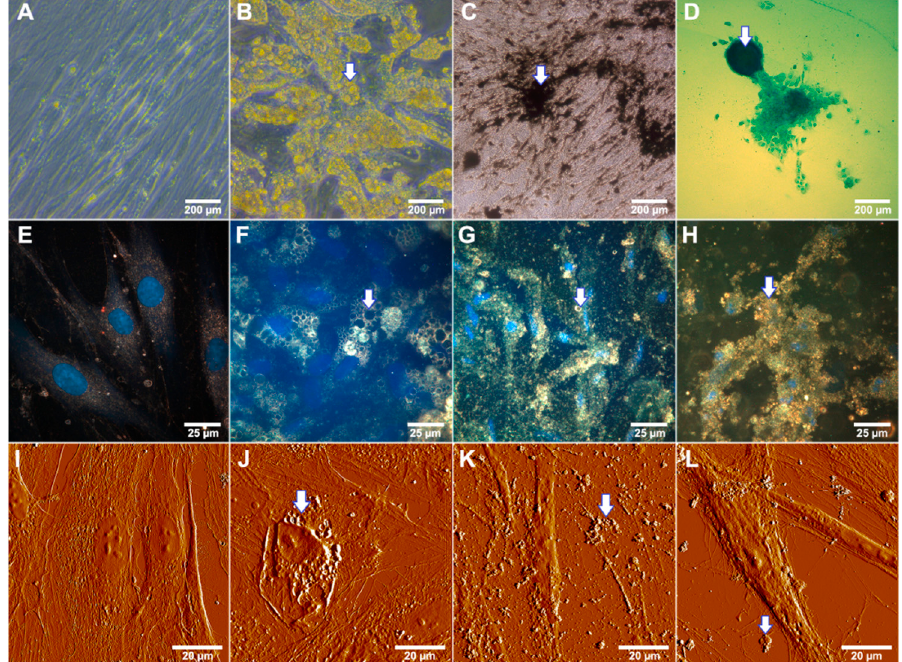
Figure 3. Differentiation potential of equine adipose derived mesenchymal stem cells after 14 d incubation in differentiat- ing media. Arrows indicate characteristic changes of cellular morphology. ( A )—cells incubated in the presence of α -MEM (negative control); ( B )—cells grown under adipogenic conditions (note a huge amount of yellow colored lipid droplets); ( C )—von Kossa staining of cells differentiated to the osteoblasts under osteogenic conditions (note the black stained cal- cium accretion); ( D )—alcian blue staining of cells differentiated to the chondrocyte lineage in chondrogenic medium (pol- yanionic glycosaminoglycan chains of proteoglycans visualized as a blue agglomerate). ( E – L )—Label-free visualization of differentiated MSCs under specific conditions, ( E – H )—dark-field microscopy; ( E )—control ( α -MEM), ( F )—adipogenic dif- ferentiation, ( G )—osteogenic differentiation, ( H )—chondrogenic differentiation; nuclei were stained with DAPI and de- tected using fluorescence mode; ( I – L )—AFM detection; ( I )—control, ( J )—adipogenic differentiation, ( K )—osteogenic dif- ferentiation, ( L )—chondrogenic differentiation.